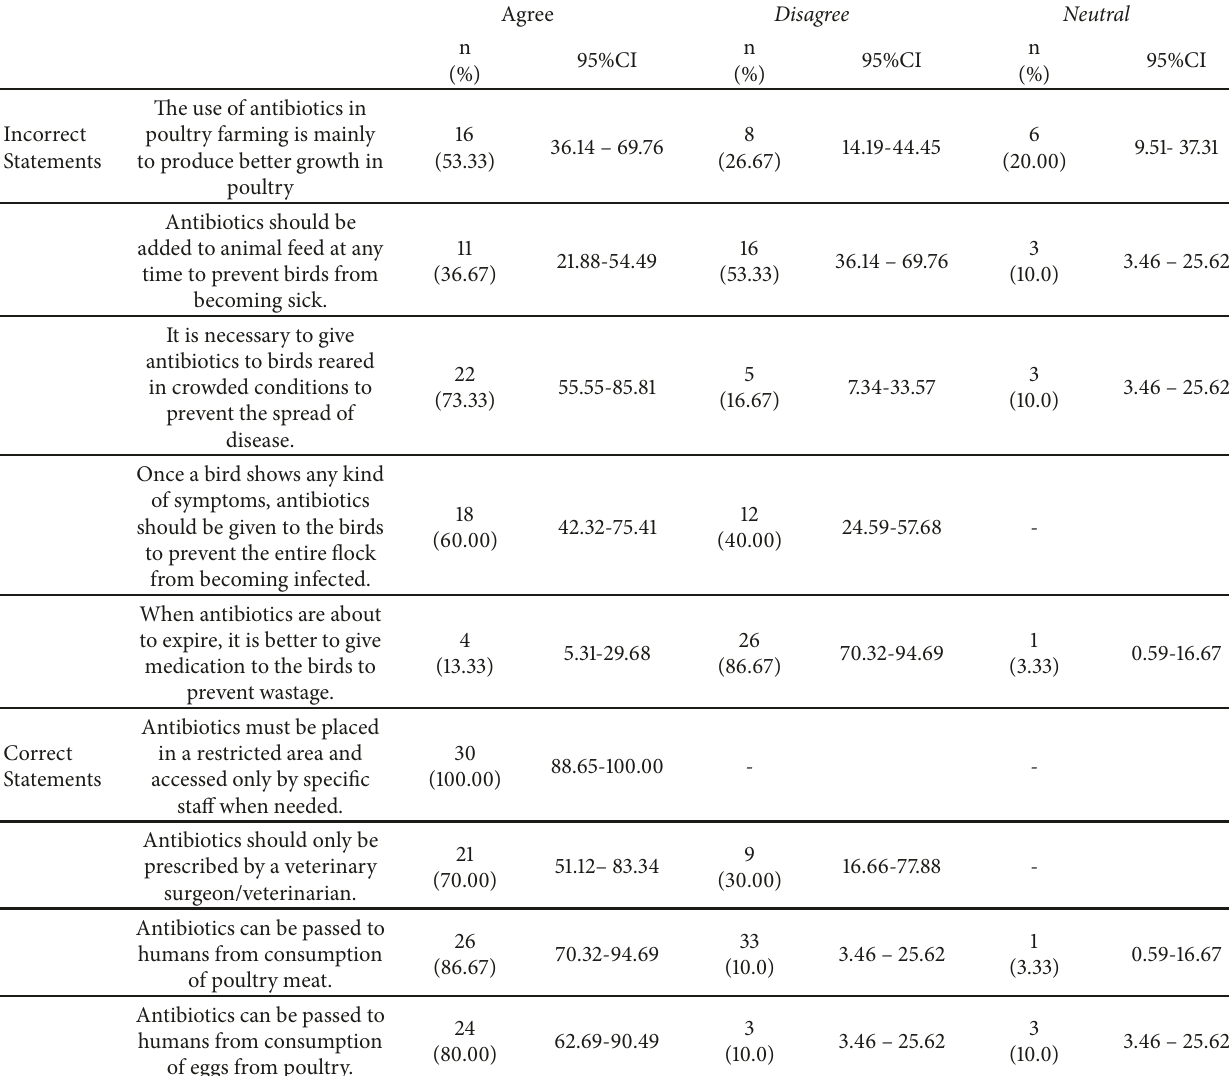
Table 2: Respondents Responses to Statements About Antibiotics and